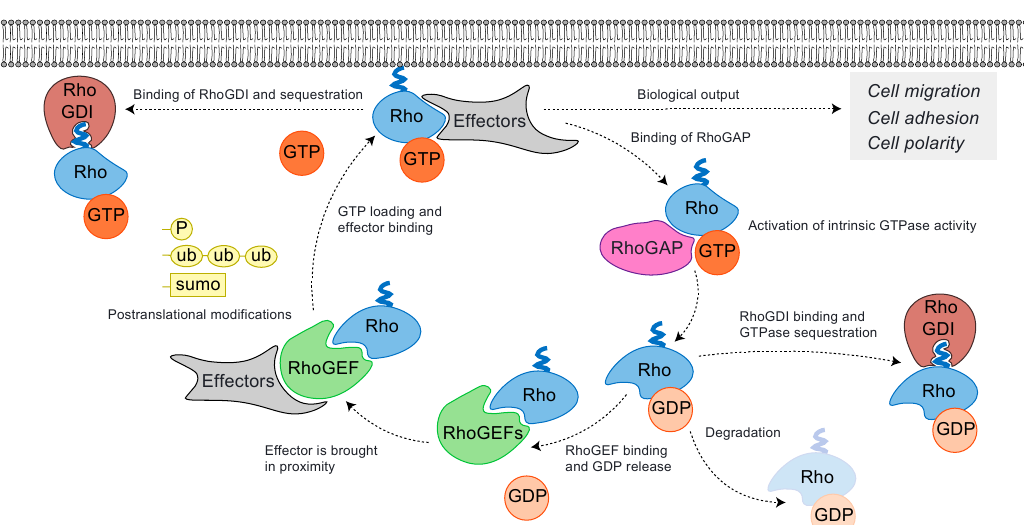
Figure 2. The classical Rho GTPase cycle and its spatiotemporal regulation. RhoGEFs activate Rho GTPases by destabilizing Rho GTPase nucleotide and Mg 2+ interaction and by promoting GTP loading, which is in excess in cells when compared to GDP. RhoGEFs also act as protein scaffolds by bringing appropriate effectors in close proximity to active Rho GTPases. Once active, Rho GTPases bind with their effectors and trigger biological effects in cells such as cell migration, cell adhesion, and cell polarity. RhoGAPs inactivate Rho GTPases by enhancing their weak intrinsic GTPase activity, which triggers the hydrolysis of GTP in GDP. RhoGDIs bind to Rho GTPases and promote the extraction of the Rho GTPases C-terminal lipid extension from the membrane which becomes ultimately hidden into the RhoGDIs hydrophobic pocket. RhoGDIs are known to sequester Rho GTPases in the cytosol and to prevent their interaction with other regulators. Rho GTPases are also heavily regulated through post-translational modifications, gene expression and their degradation.